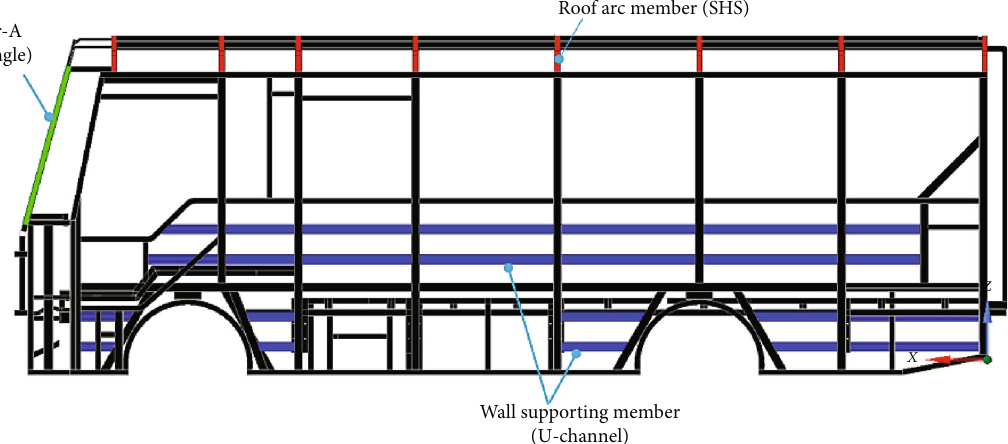
Figure 7: Selected con fi gurations of the original design in a side